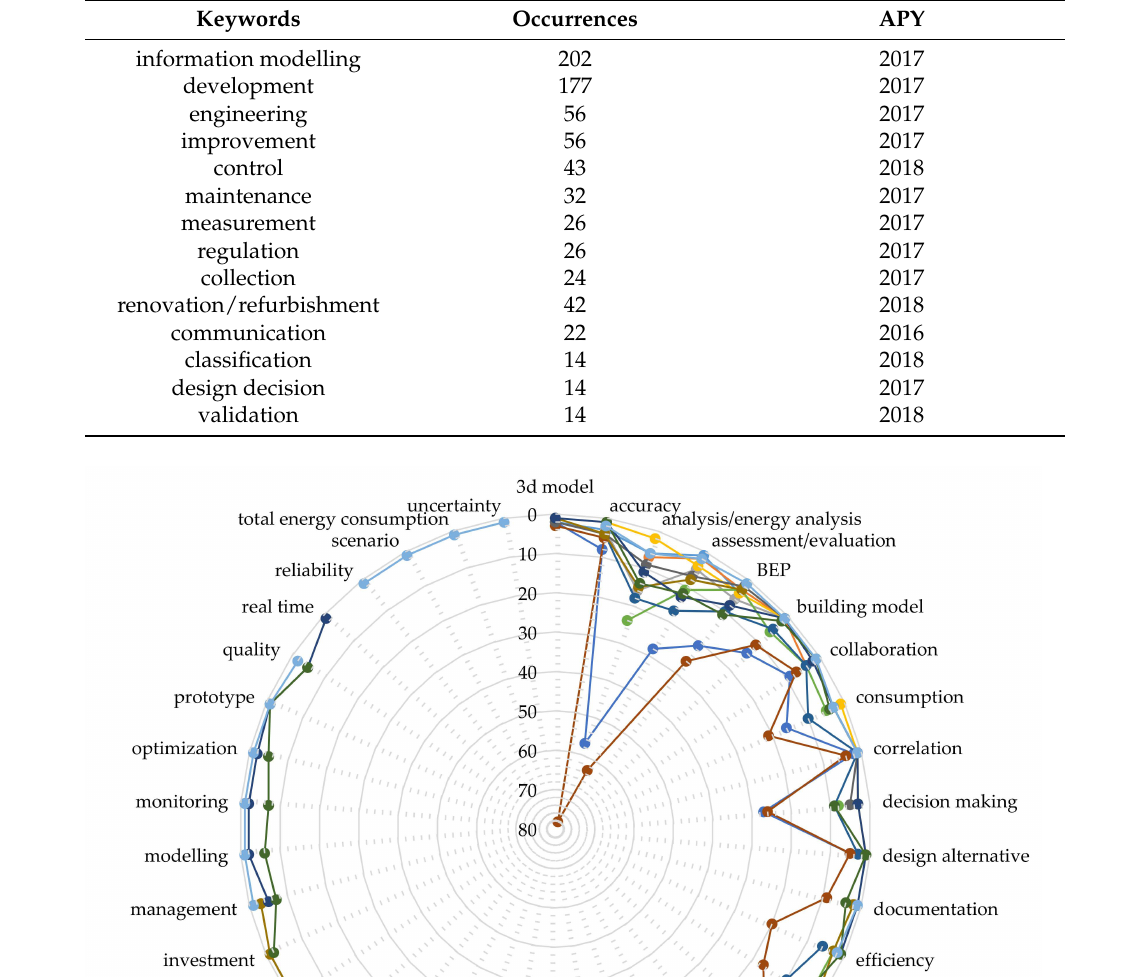
Table 5. Activities of the building’s life cycle as found in BIM and building energy efficiency analysis.